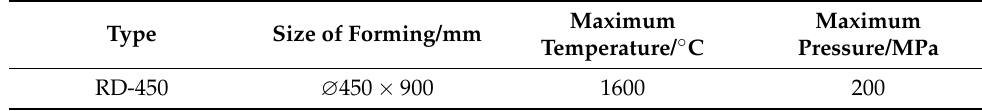
Table 2. The main parameters of the HIP equipment.